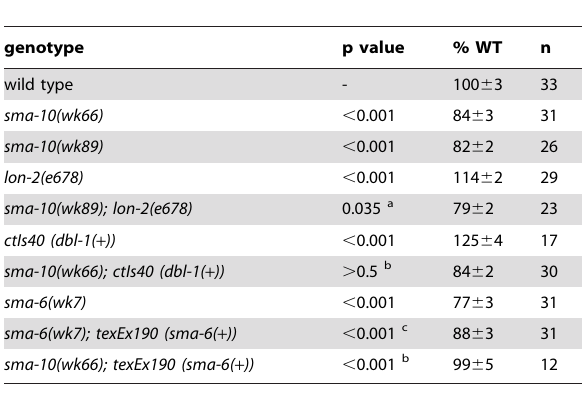
Table 2. sma-10 acts between ligand dbl-1 and receptor sma-6